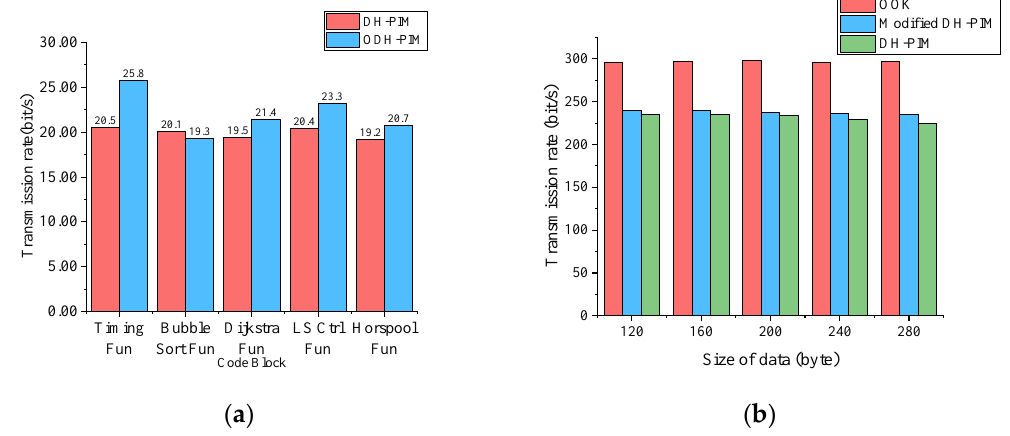
Figure 8. ( a ) Transmission rate in downlink. ( b ) Transmission rate in uplink. In the uplink, we test OOK, DH-PIM, and modified DH-PIM by transmitting feedback data in five different debugging cases. It is obviously that the amount of transmitted data using DH-PIM cannot exceed using OOK under same slots. As shown in Figure 8b, the transmission rate of OOK is faster than DH-PIM. The modified DH-PIM has a slightly higher transmission rate than DH-PIM, and its BER is significantly lower than that of DH-PIM. Figure 9 shows the debugging completion time, which consist of downlink/uplink transmission, compression and local rebuilding time. We complete VLC-based debugging interaction under outdoor and indoor environments with different ambient light intensity.